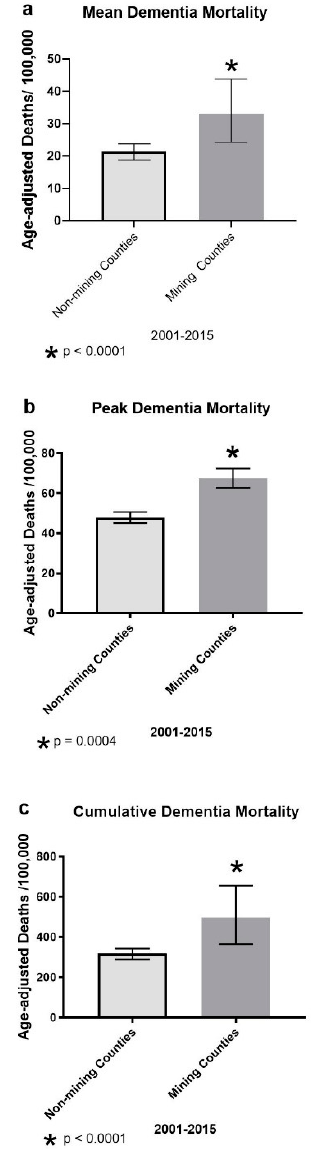
Figure 4. Mean, peak and cumulative age-adjusted vascular and unspecified dementia mortalities / 100,000 population in non-mining vs. mining WV counties over the years spanning 2000–2015. All p -values are two-tailed. ( a ) The median mean dementia mortality in mining vs. non-mining counties in West Virginia. A Mann–Whitney U test for non-parametric distributions showed this measure was significantly higher in the mining counties (U = 119). The (median) mean deaths per year from dementia for mining vs. non-mining counties over the 15 year span was respectively 33.07 vs. 21.41 age-adjusted deaths per 100,000 population (Each plotted with a 95% C.I.: ± 5.71, ± 18.75). * denotes significantly di ff erent from non-mining counties, p < 0.0001). ( b ) Mean peak dementia mortality in mining vs. non-mining counties in West Virginia over the years spanning 2000–2015. An unpaired t-test found significantly higher peak dementia mortality in the mining counties (t = 3.77; df = 52; p = 0.0004). Mining counties had a mean ( ± SEM) peak value of 67.5 ± 4.81 age-adjusted deaths per 100,000 populations vs. 47.83 ± 2.82 for the non-mining counties. * denotes significantly di ff erent from non-mining counties; p = 0.0004). ( c ) As for cumulative dementia, a Mann–Whitney U test (again these data were non-parametric) showed significantly higher cumulative dementia mortality in MTM counties (4C; U = 121; p < 0.0001). The median cumulative death rates from dementia were 496 vs. 318 per 100,000 (Each plotted with a 95% C.I.: ± 87.5, ± 279.7).